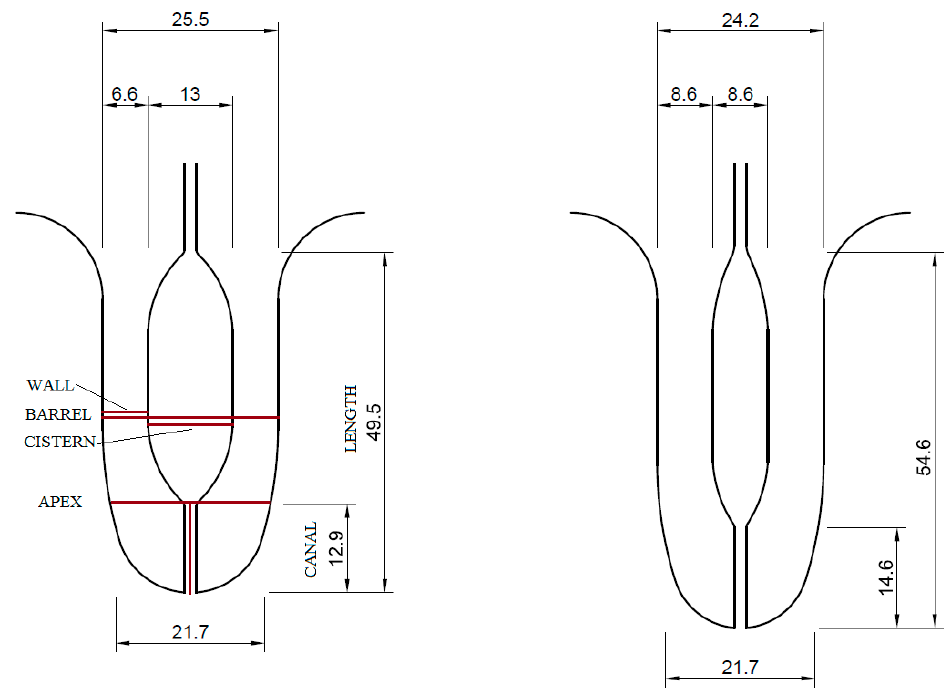
Figure 1. An illustration of the average size of the teat structures before ( left ) and after ( right ) milking in mm, with the location of the measurements. Only the teat wall further from the probe was measured, and sometimes it was measured at a different angle than barrel thickness, which, together with the standard deviation, caused a slight discrepancy between barrel thickness and the thickness of wall + cistern +